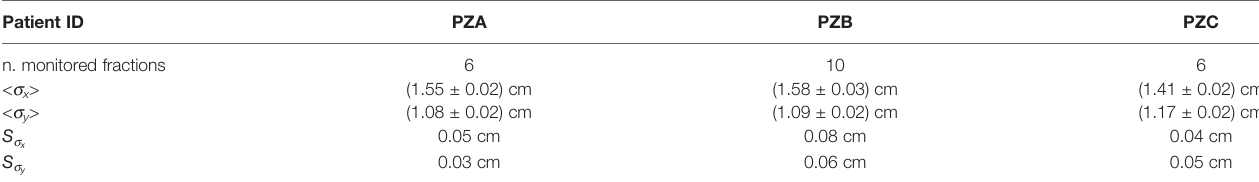
, s s of the resolutions obtained in the different treatment fraction for PZA, PZB and PZC. x y